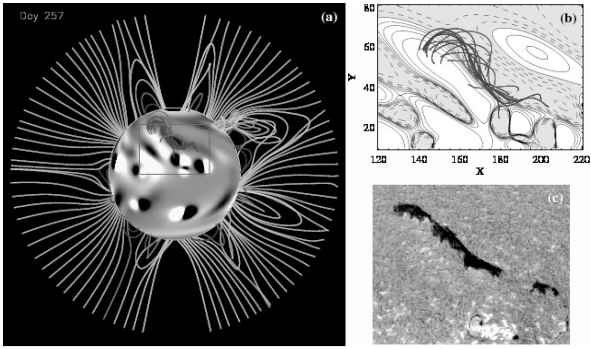
Figure 10. (a) A non-linear force-free model of the solar corona from a global simulation after 108 days of evolution, showing highly twisted flux ropes, weakly sheared arcades and near-potential open fields. (b) A close-up showing a twisted flux rope lying above part of the polarity inversion line and (c) the associated solar promi- nence observed by Big Bear Solar Observatory in Hα (courtesy of Duncan Mackay).